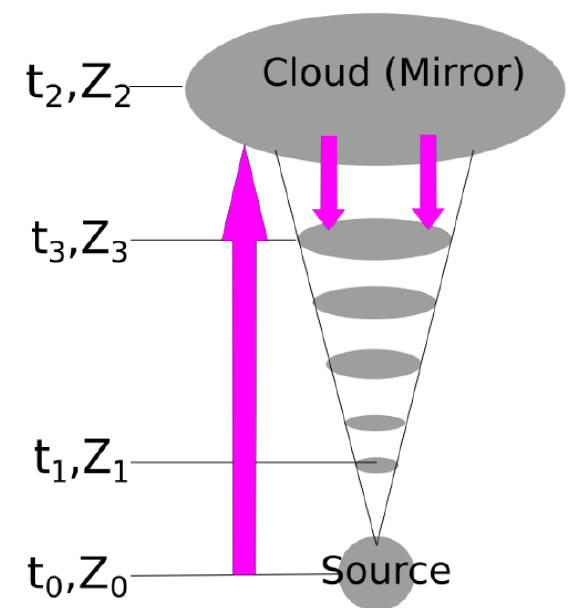
Figure 13. Sketch of a synchrotron mirror model. From Oberholzer & Böttcher (2019, in preparation).